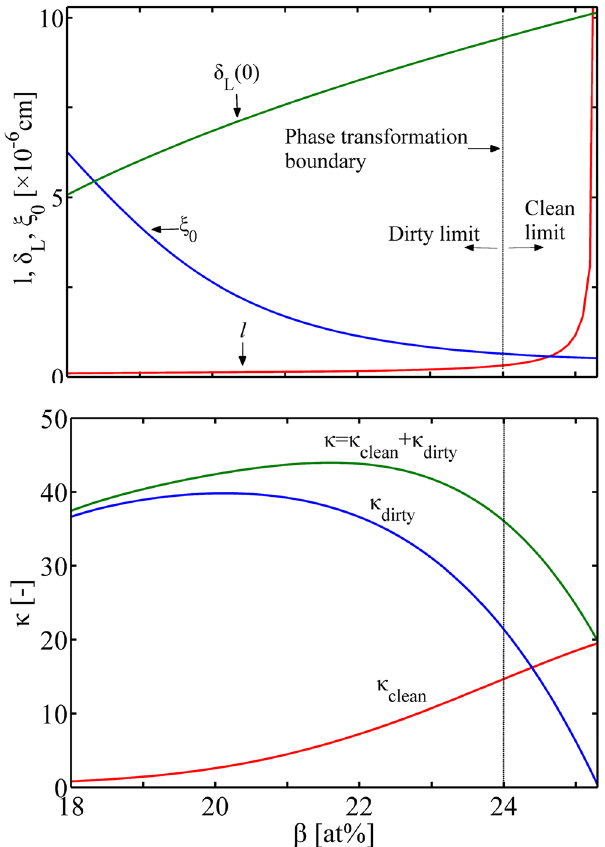
Figure 2. Composition dependence of the London penetration depth δ L (0), coherence length ξ 0 and electronic mean free path l (Top), and the GL parameter κ